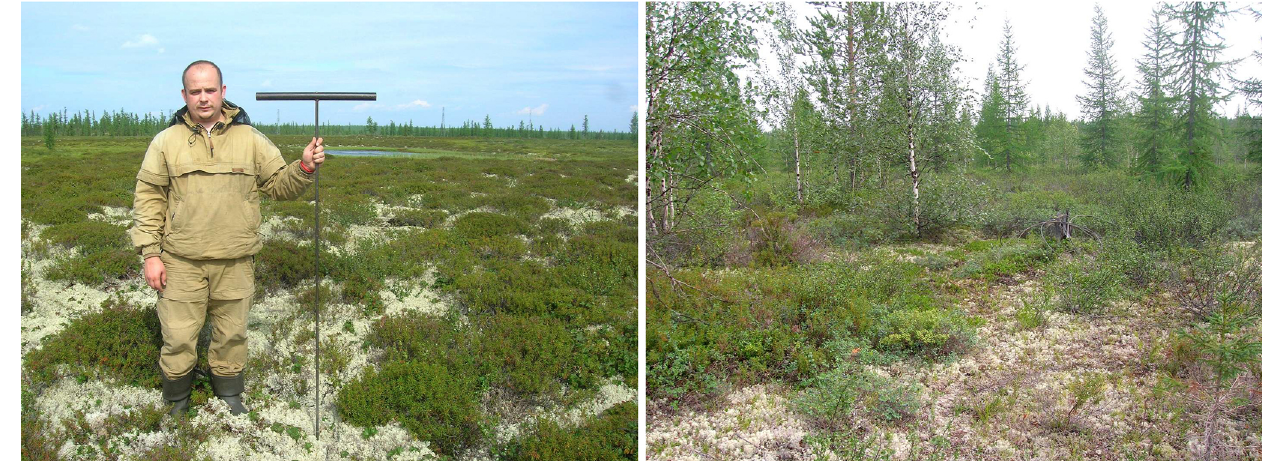
Figure B1. Illustration of vegetation cover in the photos from the field campaign: the non-disturbed site (left panel) and the nearby site affected by fires before 1968 and 1988 (right